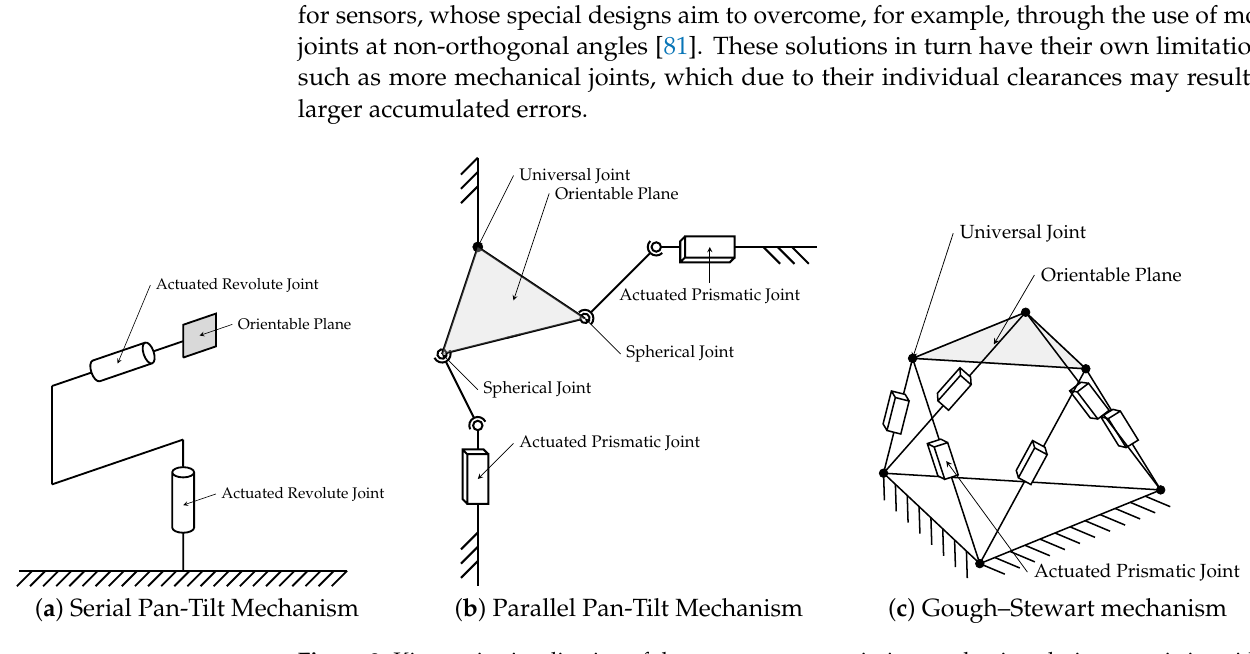
Figure 3. Kinematic visualization of the most common pointing mechanism designs consisting either of ( a ) serial or ( b , c ) parallel